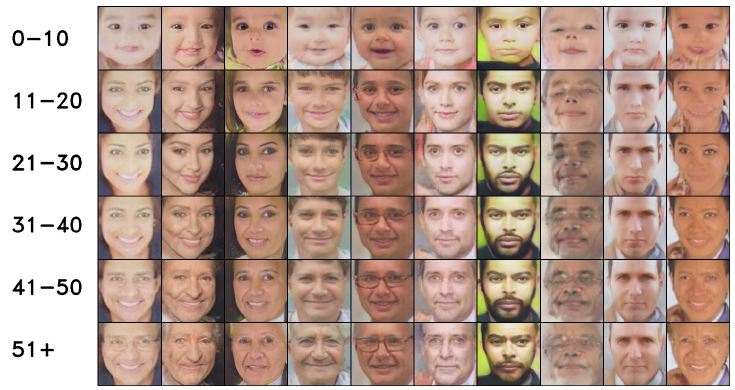
Figure 5. The results from cstyleGAN (time flows from top to bottom